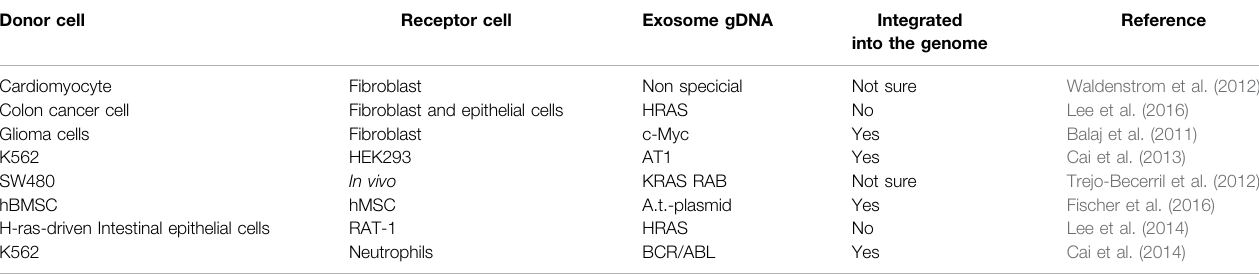
TABLE 2 | Exosome gDNA transfer between